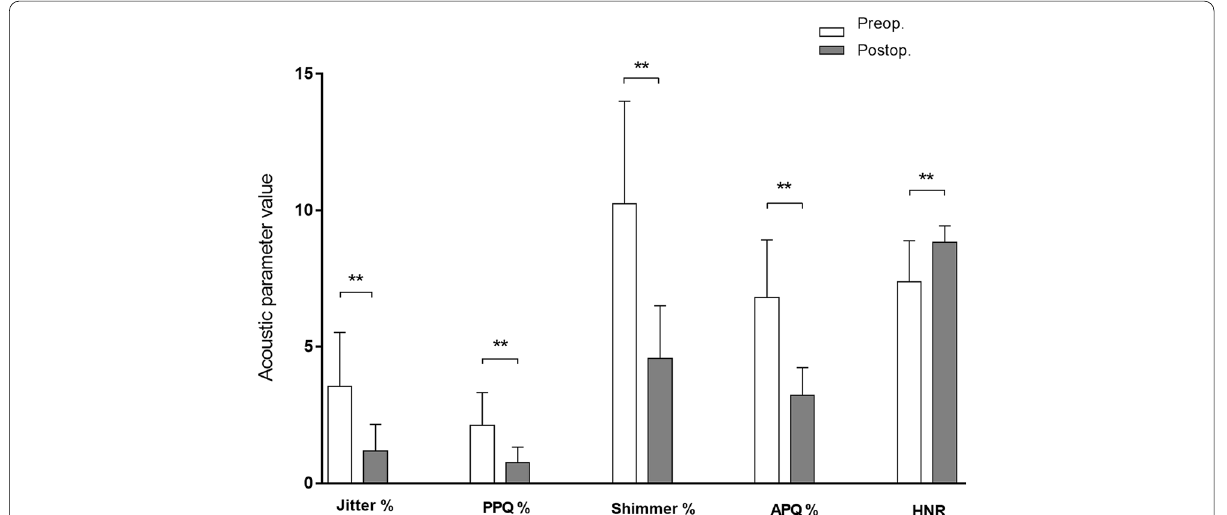
Fig. 4 This figure shows the outcomes of acoustic voice parameters after operation. Note the significant improvement of all voice parameters (increase of HNR and decrease of other parameters). HNR: harmonics‑to‑noise ratio, PPQ: pitch perturbation quotient, APQ: amplitude